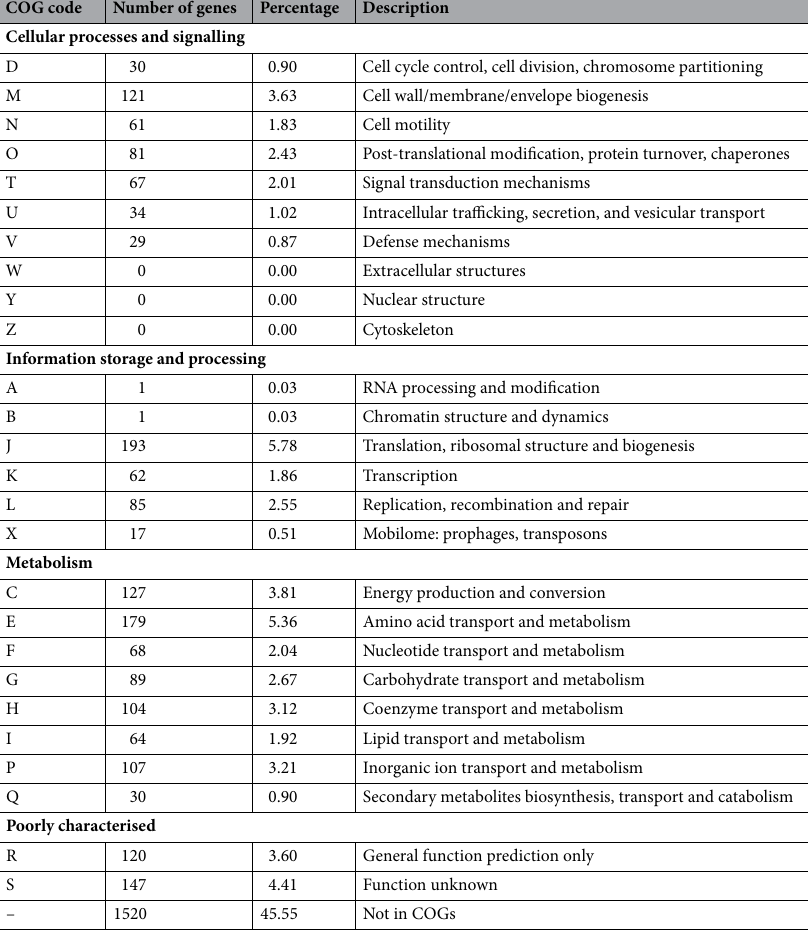
Table 2. Number of genes associated with the general cluster of orthologous group (COG) functional categories in H. malpeensis YU-PRIM-29 T genome.